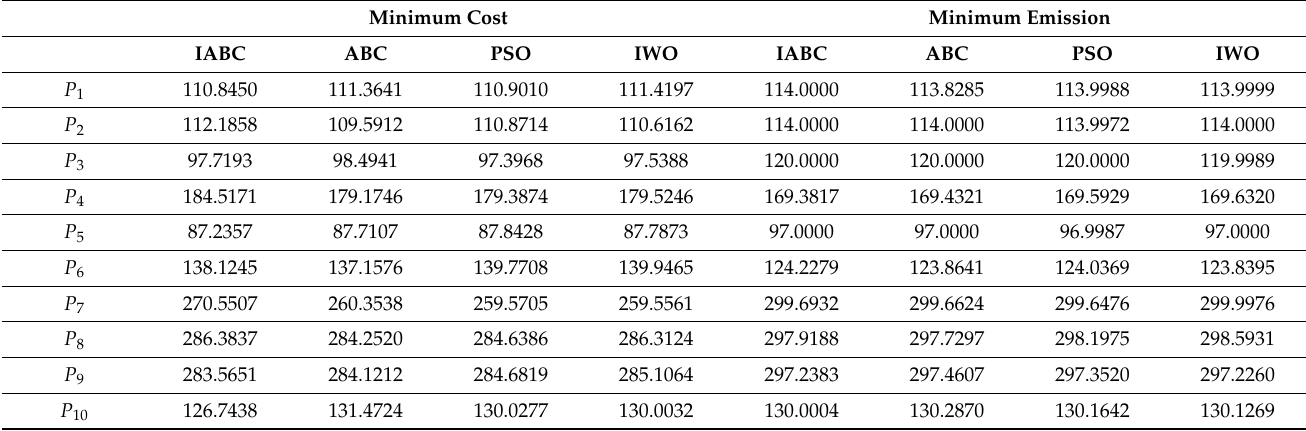
Table A5. Minimum cost and minimum emission (Case